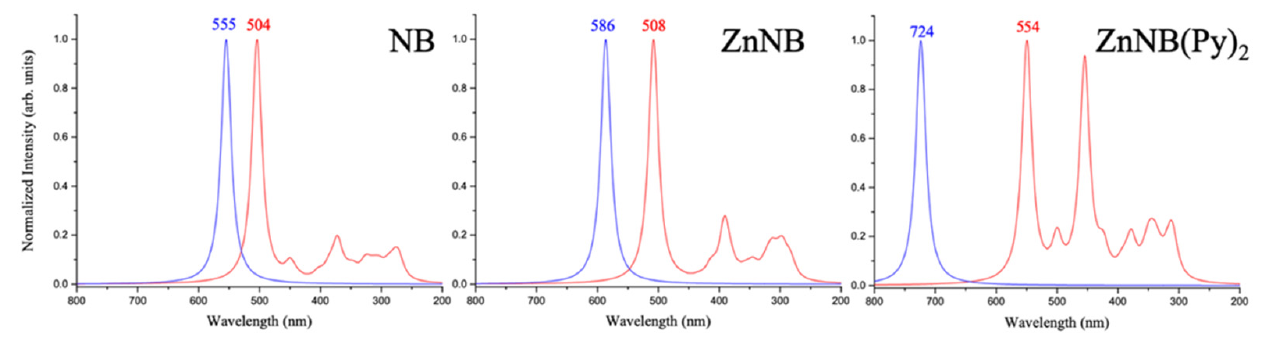
Figure 4. Absorbance (red line) and emission (blue line) simulated spectra for NB, ZnNB, and ZnNB(Py) 2 .